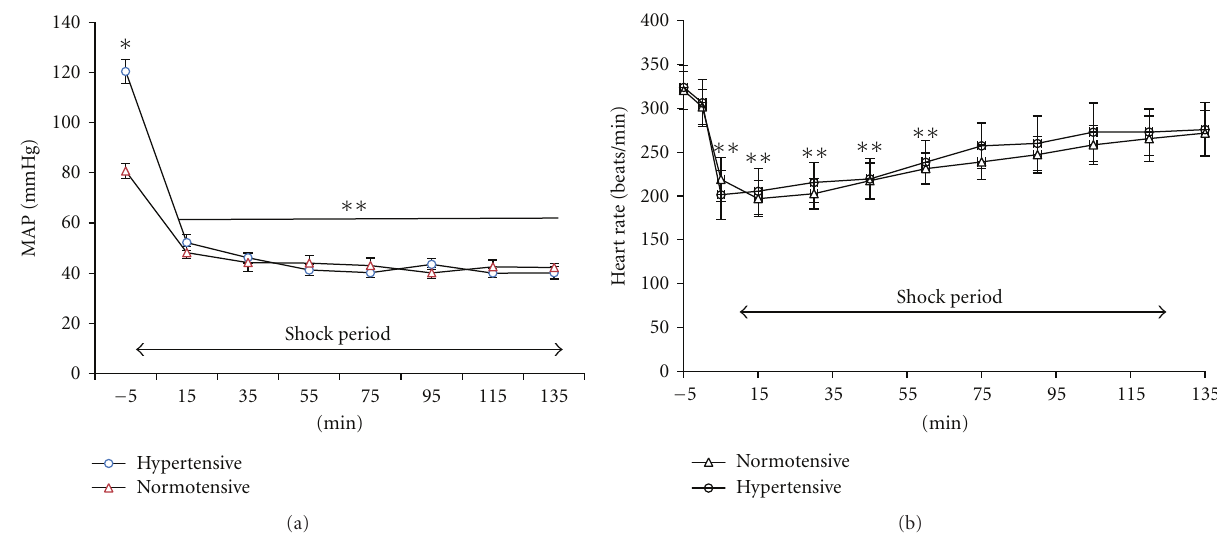
Figure 1: Changes of MAP (a) and HR (b) during shock period in normotensive and hypertensive rats. ∗ P < 0 . 05 compare to normotensive group. ∗∗ P < 0 . 05 compared to before